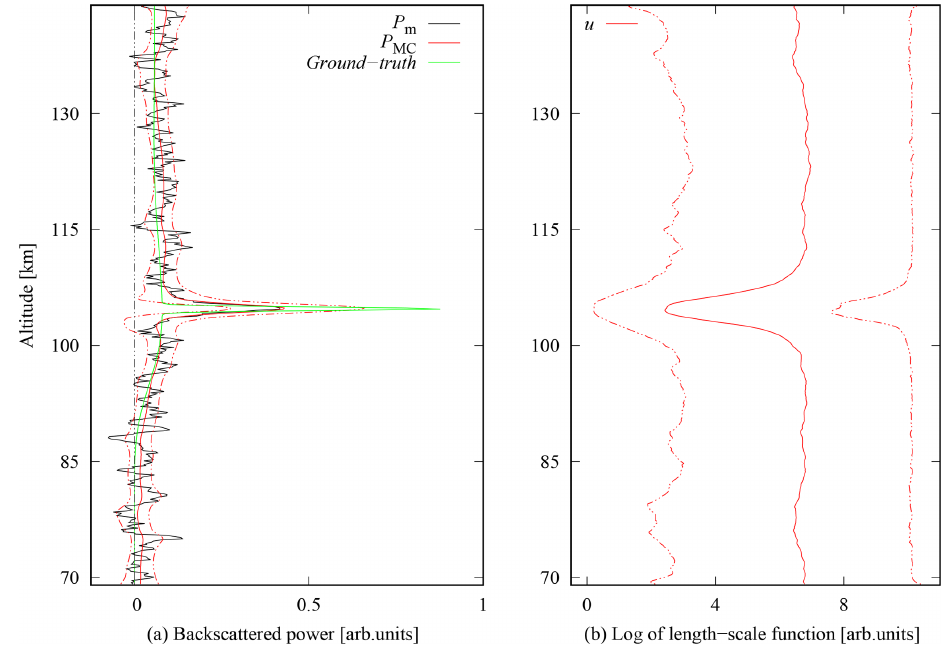
Figure 4. Panel (a) shows synthetic signal reconstruction with MCMC drawn with blue solid line and 95% credible intervals with dashed lines for α MC = 0 . 5. Reconstruction with the MCMC is plotted in comparison to the true power profile (green line) and reconstruction with the Cauchy difference prior (red line). Panel (b) represents corresponding values of length-scale function in logarithmic